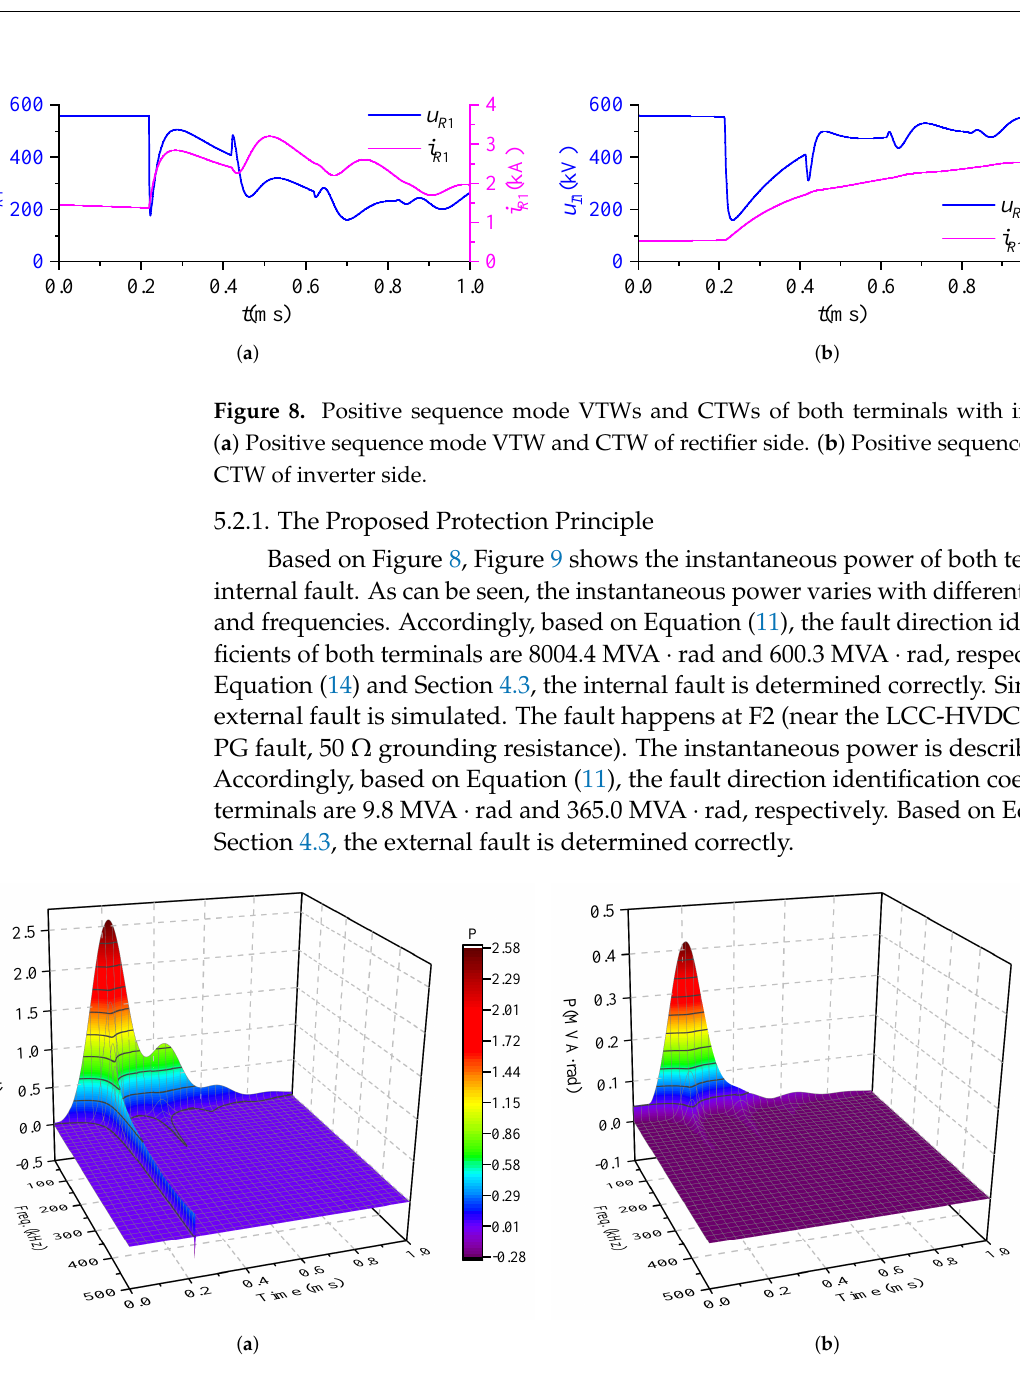
Figure 9. Instantaneous power of both terminals with internal fault (F1). ( a ) Instantaneous power of rectifier side. ( b ) Instantaneous power of inverter